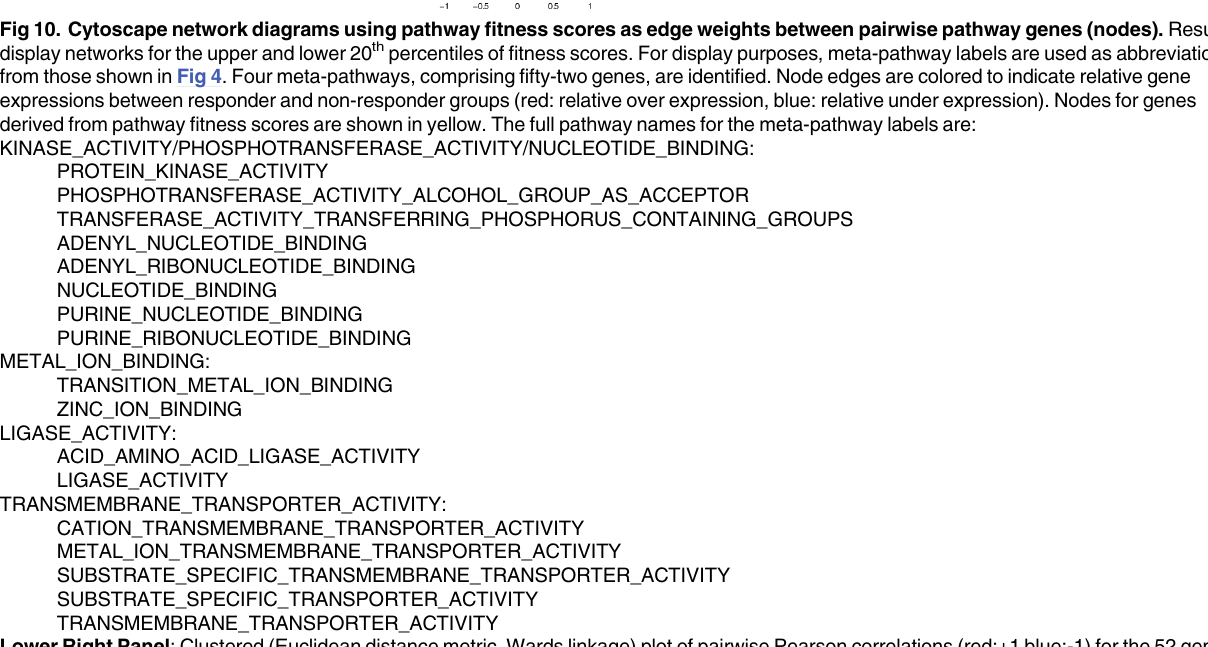
Lower Right Panel : Clustered(Euclideandistancemetric, Wards linkage)plot of pairwisePearson correlations (red:+1 blue:-1) for the 52 genes